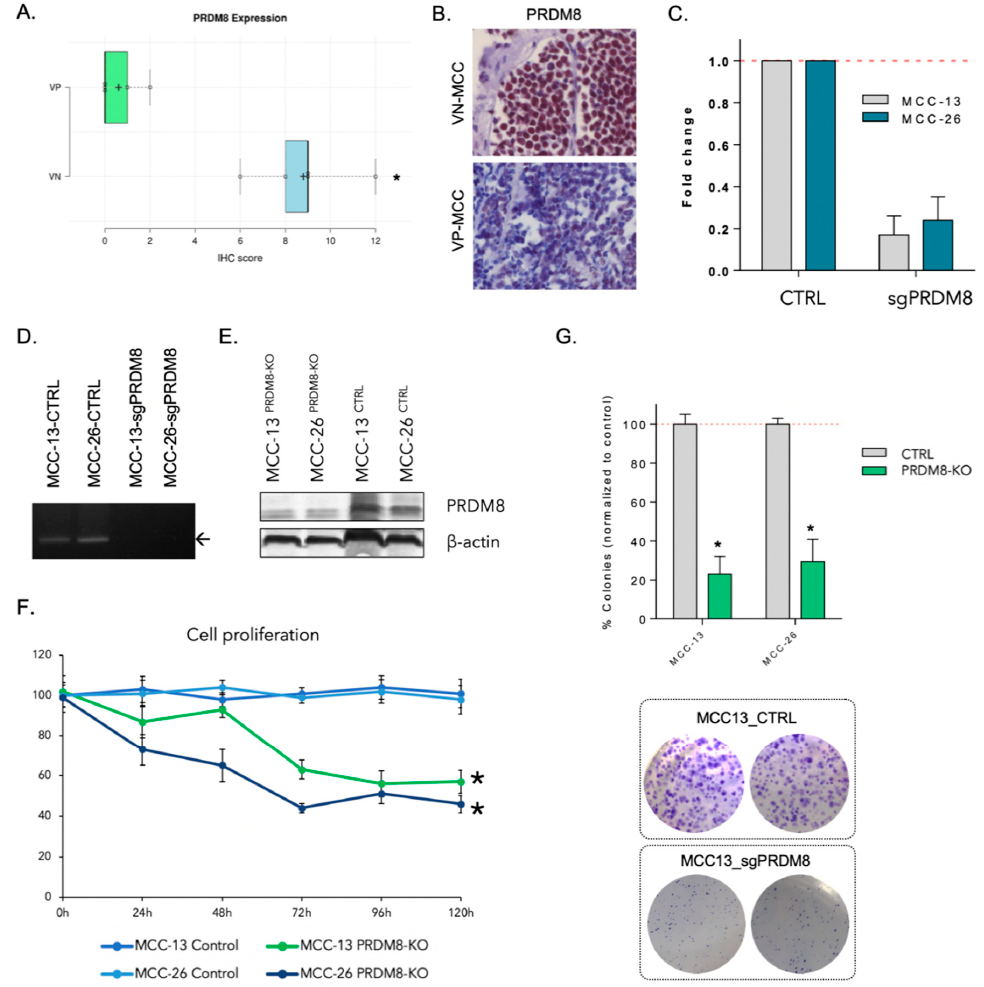
Figure 2. ( A ) Analysis of immunohistochemistry (IHC) performed in VN- and VP-MCC